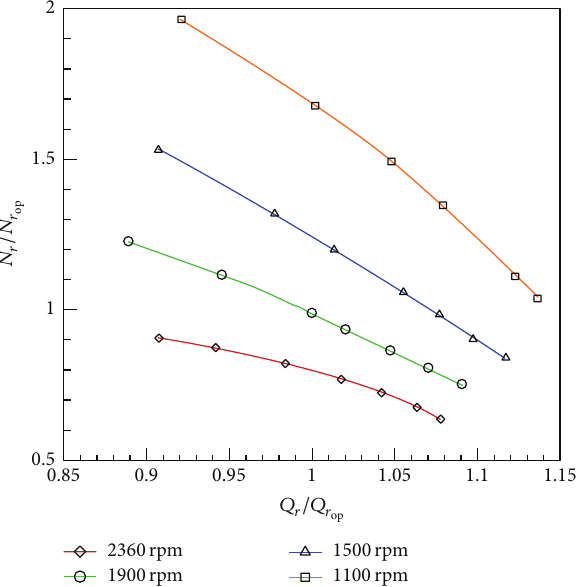
Figure 5: Hydraulic efficiency.